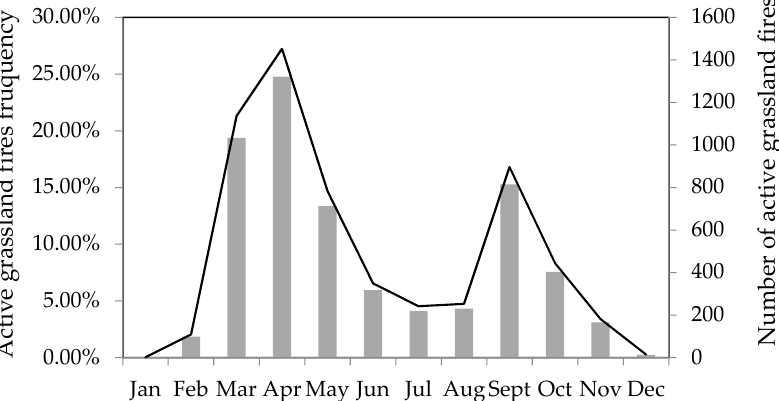
Figure 3. The annual distribution of active grassland fires in the study area. The line shows the number of active grassland fires; the bar shows the active grassland fires frequency.